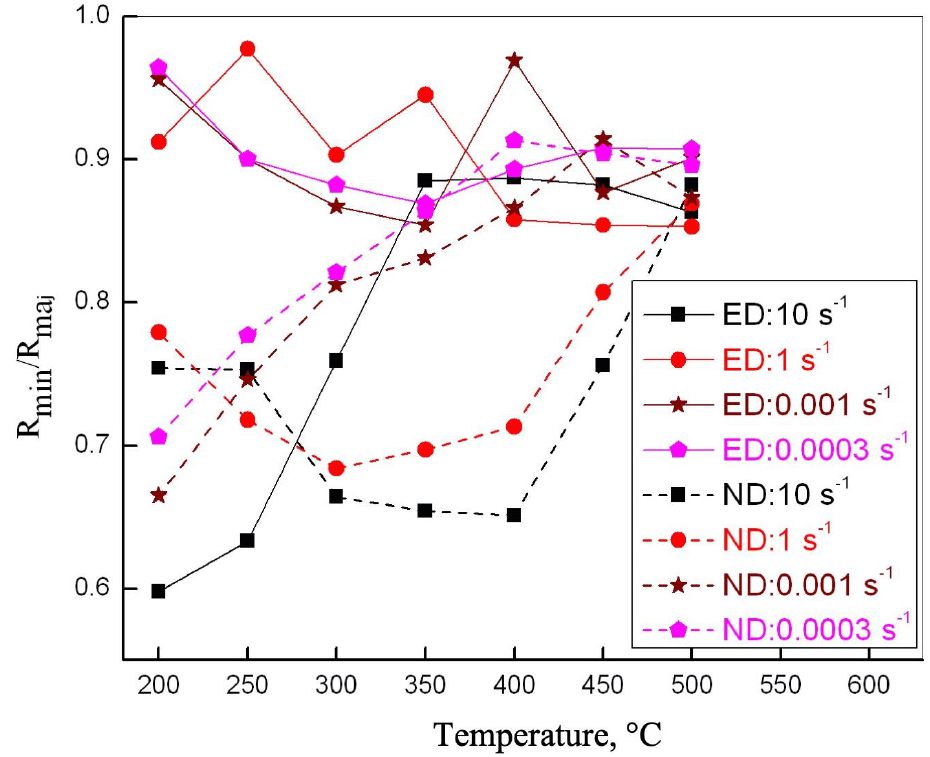
Figure 6. Effect of temperature and strain rate on a ratio of the minor to major radius of the ZK60-T5 specimens deformed along the ED and ND directions.